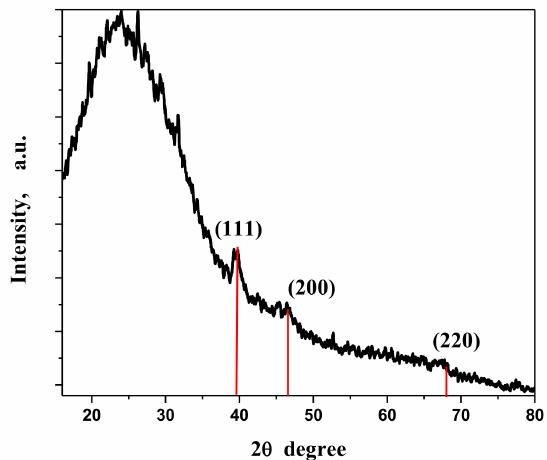
Figure 7. XRD patterns of the biosynthesis of palladium nanoparticles.